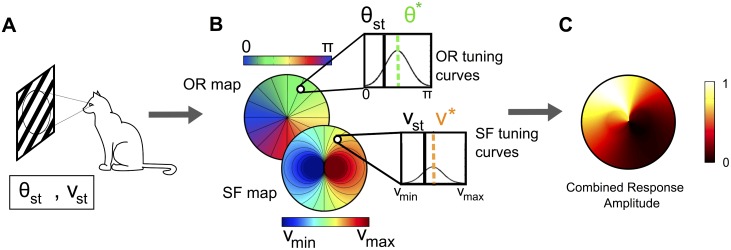
Activity maps generated from a given topology.(A): A grating with OR and SF (θ
st, ν
st) activates cells of the PA whose organization (preferred values (θ*, ν*)) is either assumed orthogonal or PD (B). The activity map, given by the level of activity of the different cells (C) is constructed using the tuning curves of the OR and SF.